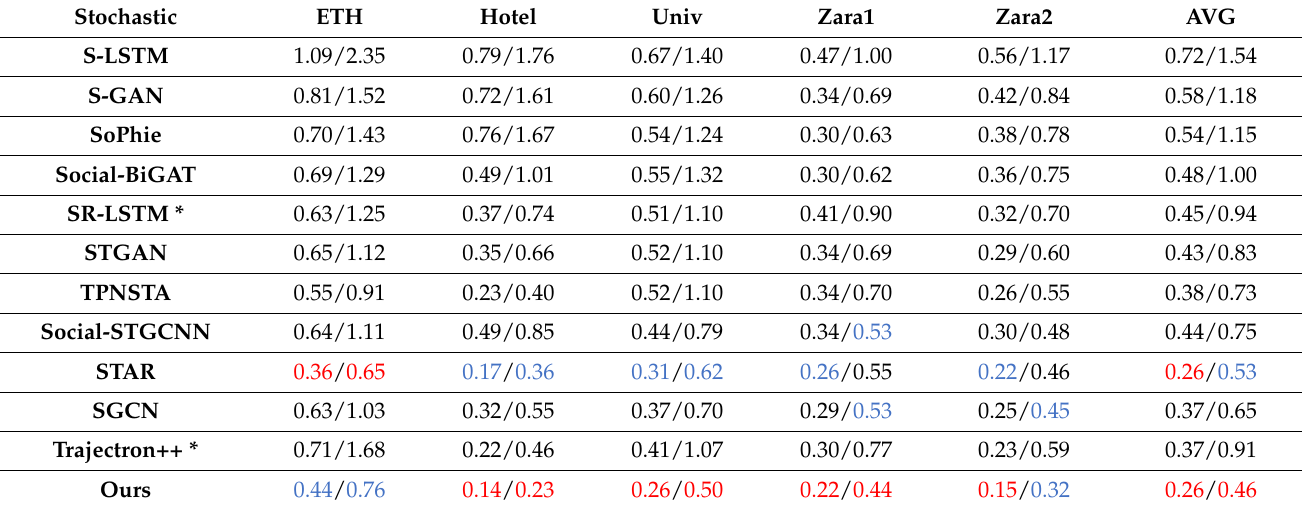
Table 1. ADE/FDE metrics for several methods compared to At-VD-GCN are shown. The models marked with * are non-probabilistic. The rest of models use the best amongst 20 samples for evaluation. All models take 8 frames as an input and predict the next 12 frames. We notice that At-VD-GCN has the best average error on both ADE and FDE metrics (the lower the better).